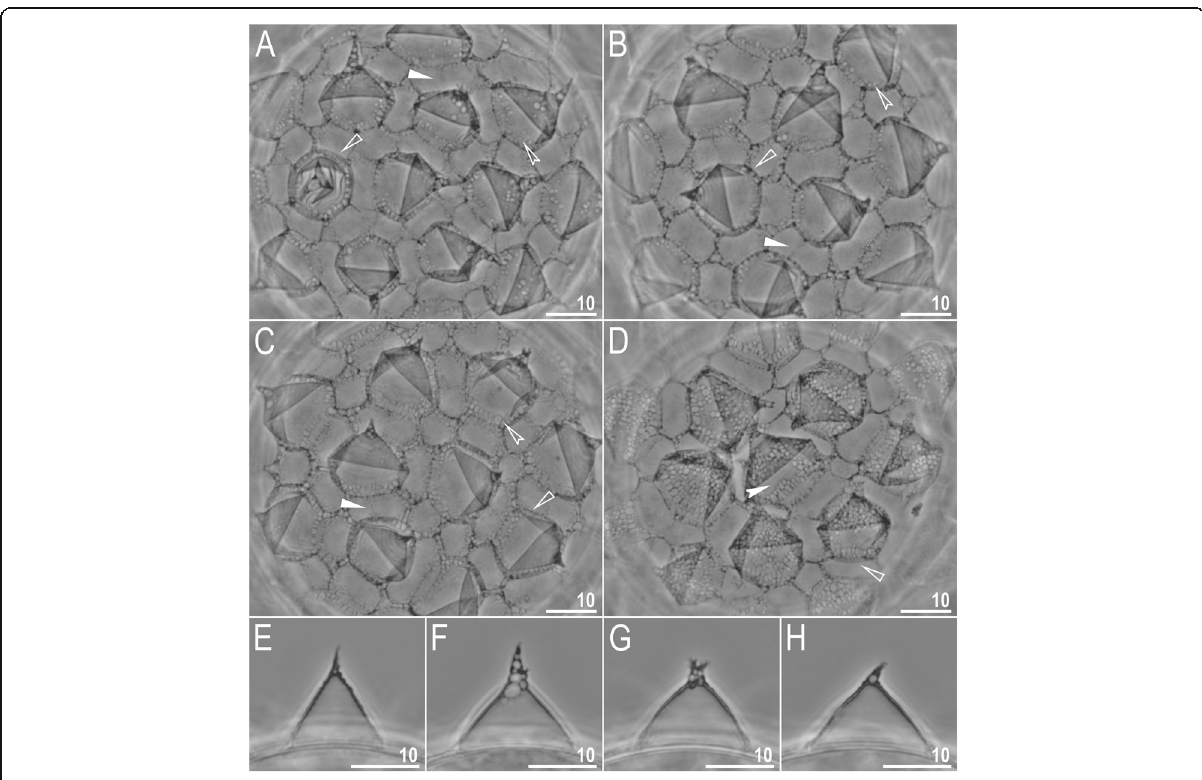
Fig. 27 Macrobiotus ripperi sp. nov. from Poland (PL.015) – eggs seen in LCM: a – d – surface under ×1000 magnification of four different eggs; e – h – midsections of four different egg processes. The filled flat arrowhead indicates thickening perpendicular to the process base that divides the areola in the middle, the filled indented arrowhead indicates areas of the egg processes without a reticulation/labyrinthine layer, empty indented arrowheads indicate rings of the reticulation/labyrinthine layer in the bottom part of egg processes, and empty flat arrowheads indicate irregular collars around process bases. Scale bars in μ